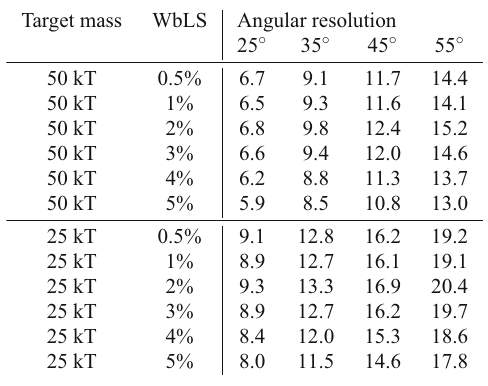
Table 5 CNO flux sensitivity (%) as a function of target mass, WbLS % and angular resolution for 5 years of data and 60% PMT